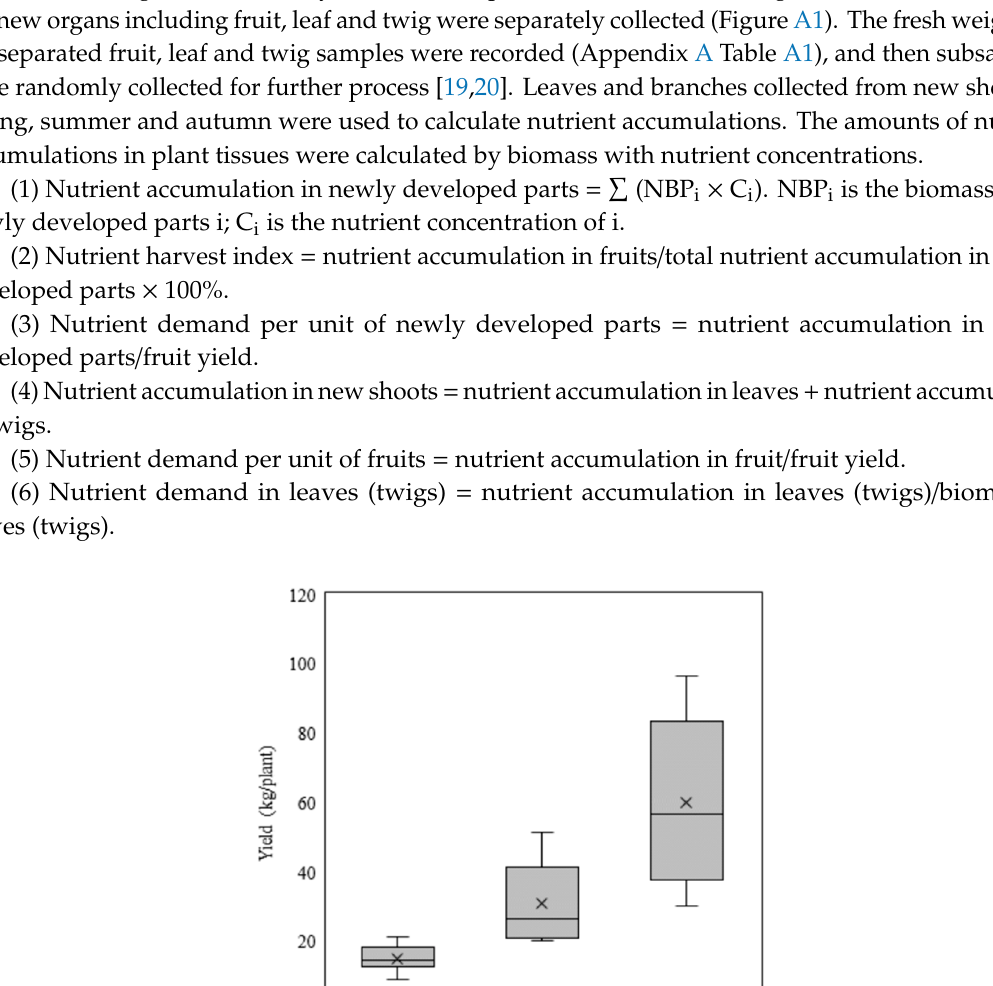
Figure 1. The yield of citrus trees in different orchards.